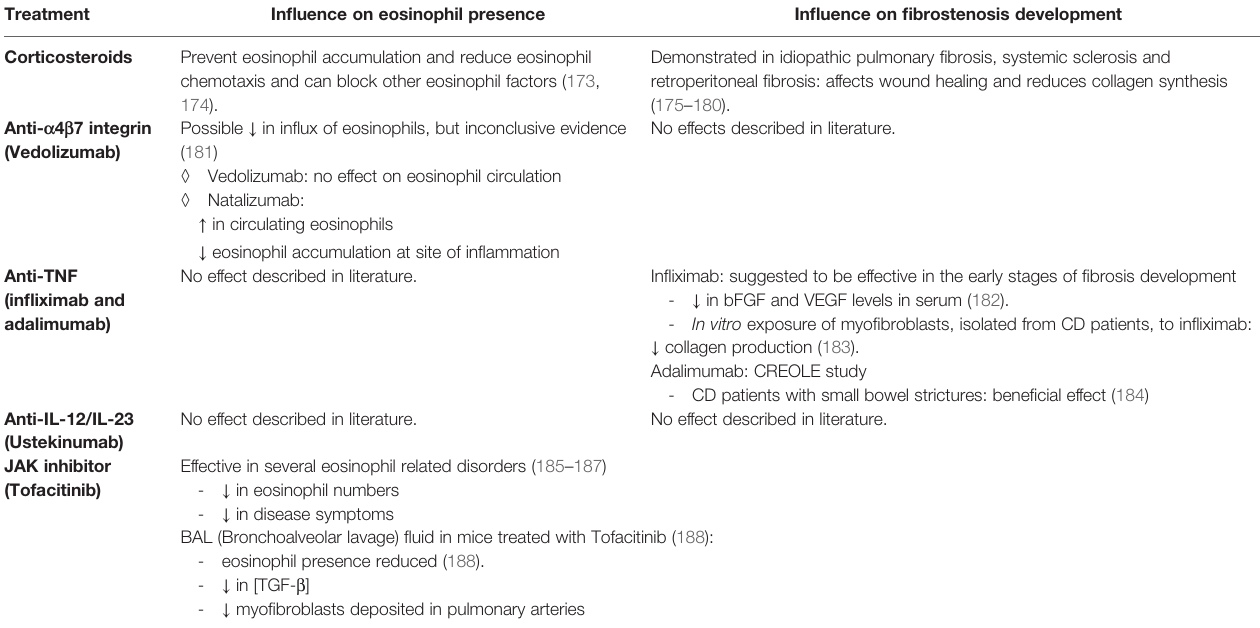
TABLE 2 | Conventional treatment options for IBD patients. Treatment In fl uence on eosinophil presence In fl uence on fi brostenosis development